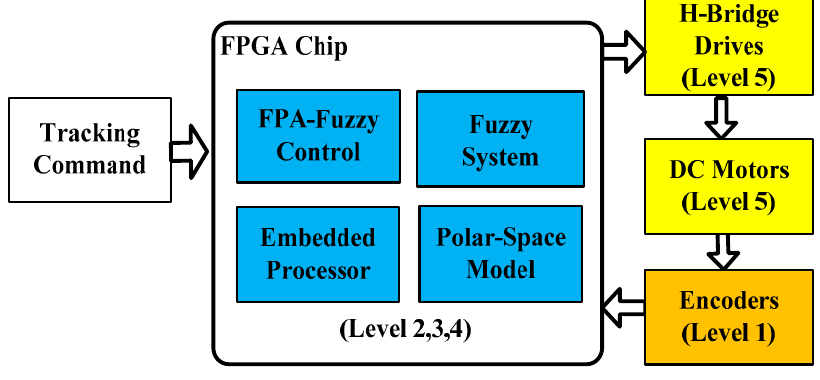
Figure 4. 5C architecture of the embedded cyber-physical Mecanum robotic system.